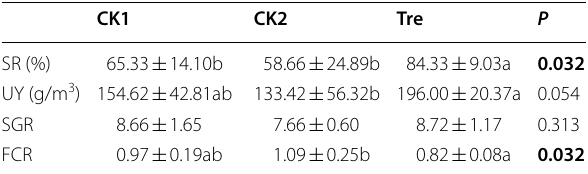
Table 1 Survival ratio (SR), unit yield (UY), and specific growth ratio (SGR) of shrimp and the feed conversion ratio (FCR) after